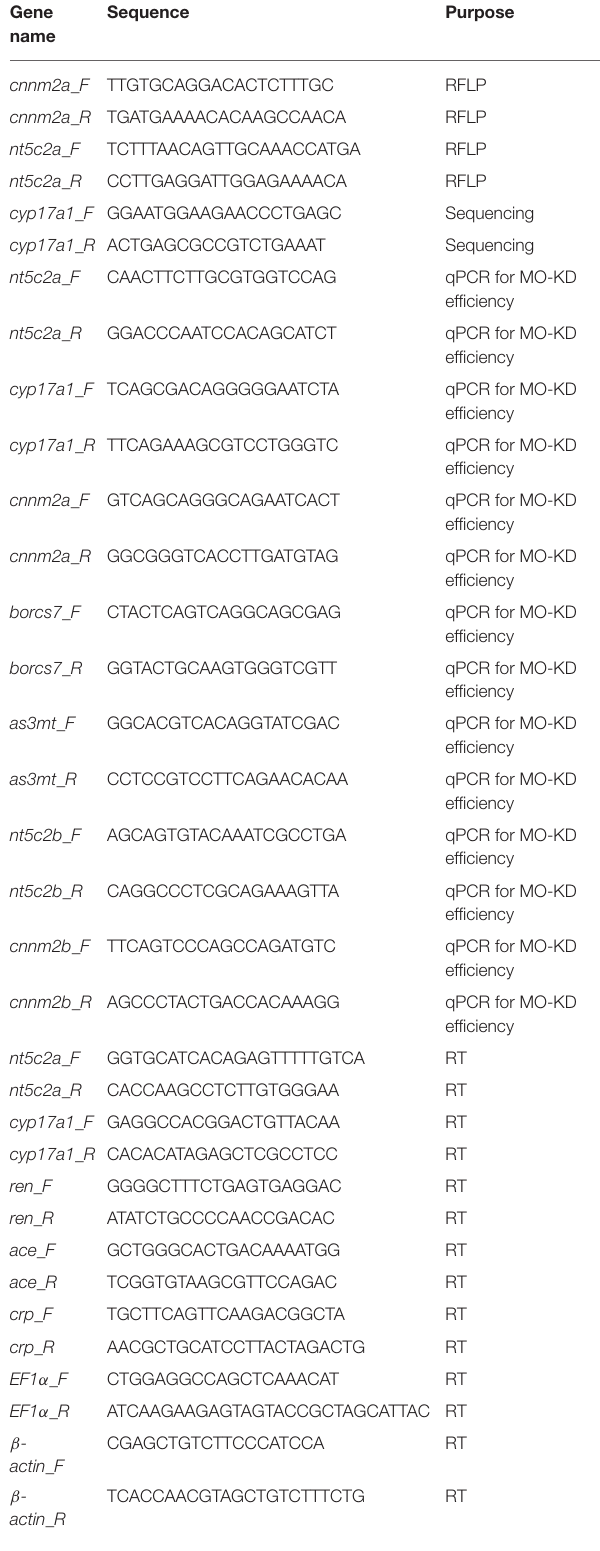
TABLE 1 | Table below consists of all the primer (forward and reverse) names and their respective sequences used during the whole